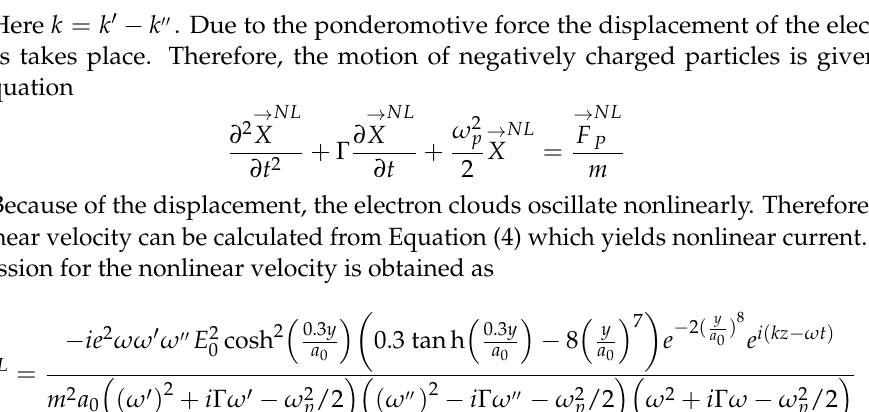
Figure 2. Schematic of the interaction of hat top beams and a medium containing graphite nanocylin- ders with parallel and/or perpendicular orientation of their basal planes.